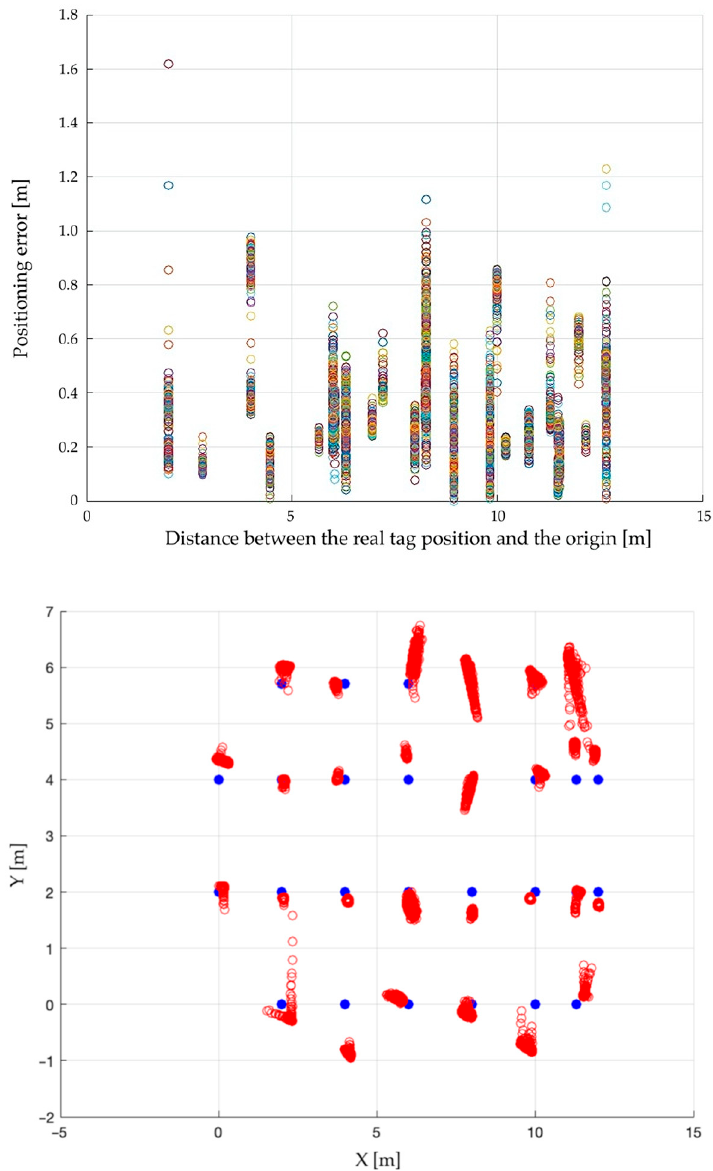
Figure 6. Positioning error plot for each sample ( above ) and map ( below ).